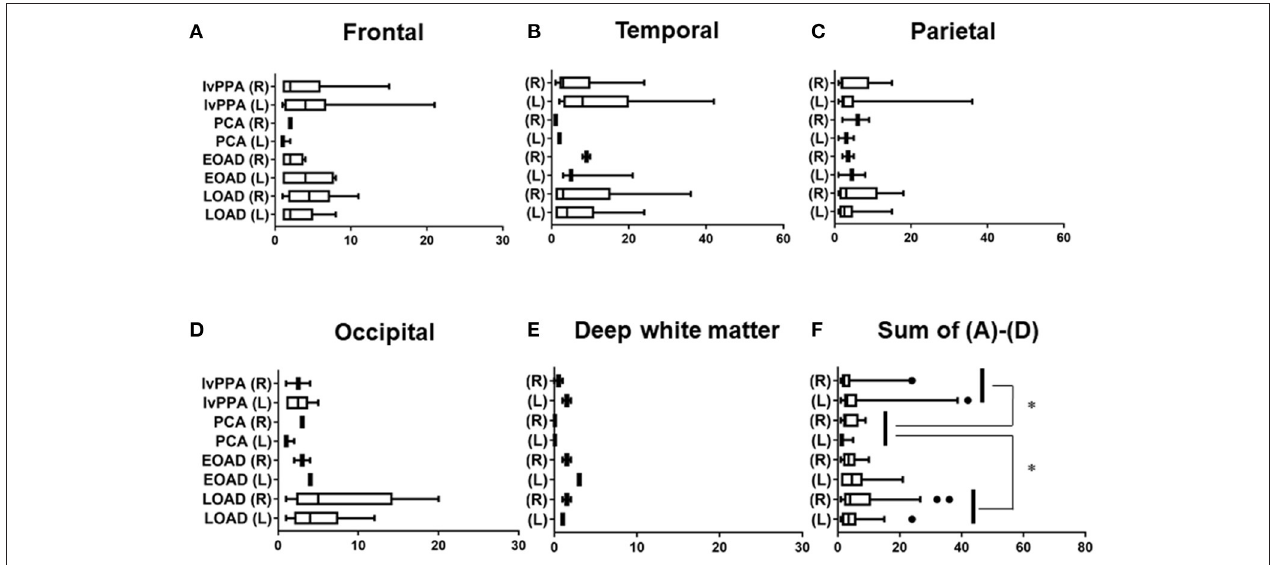
FIGURE 1 | Regional comparison of the number of CMBs in the four subtypes of AD. Number of lobar CMBs in frontal (A) , temporal (B) , parietal (C) , occipital (D) lobes, and deep white matter (DWM) (E) of lvPPA, PCA, EOAD, and LOAD. Total number of lobar CMBs in frontal, temporal, parietal and occipital lobe cortices (F) . * p < 0.05.